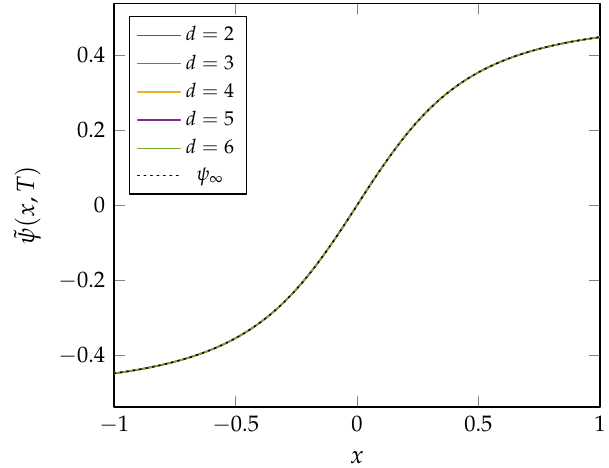
Figure 15. Time history of the relative error between transient and stationary solution in H 0 ( Γ ) norm for increasing degrees of B-spline (left) and Lagrangian (right) shape functions on a uniform spatial T = 100. Additionally, ψ ∞ ( x ) has been reported in Figure 16 and, as one can observe, all the discretization of size ∆ x = 0.2. The time interval [ 0,100 ] has been decomposed into 500 time steps of curves related to the approximate solutions overlap the curve related to the stationary one. size ∆ t = 0.2.